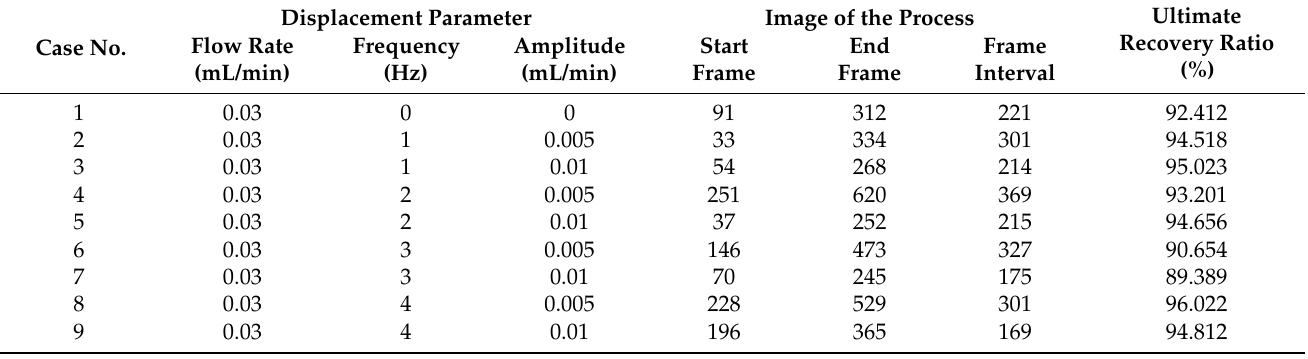
Table 2. The experimental scheme and results.